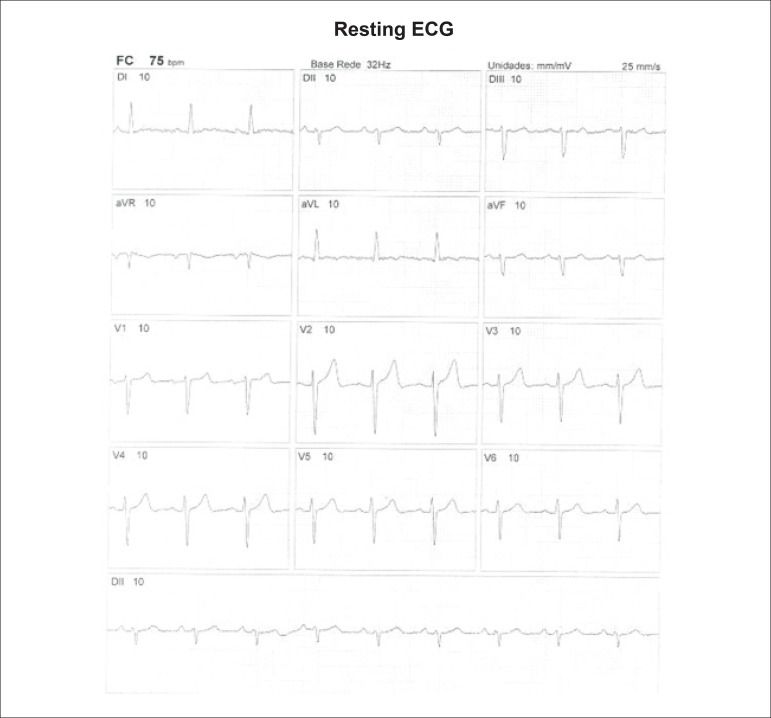
Case 2 - Resting electrocardiogram suggestive of left anterior fascicular block.